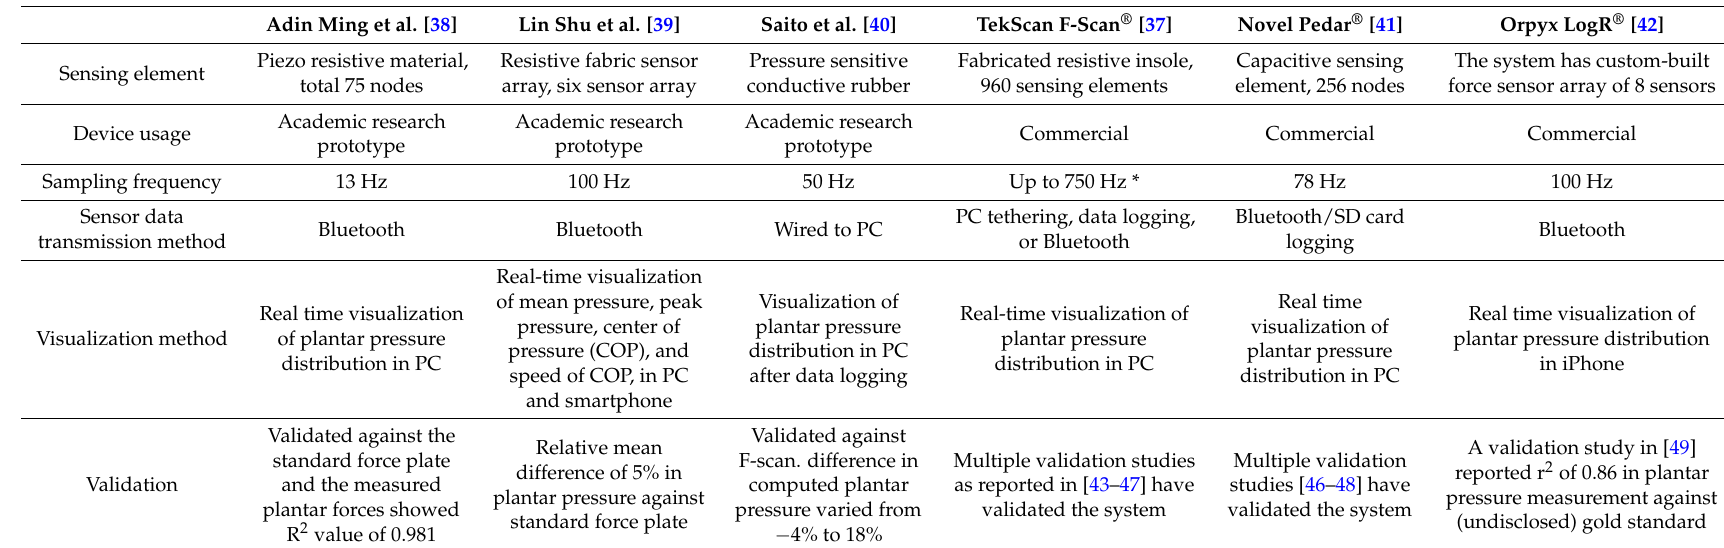
Table 2. Comparison of plantar pressure measurement